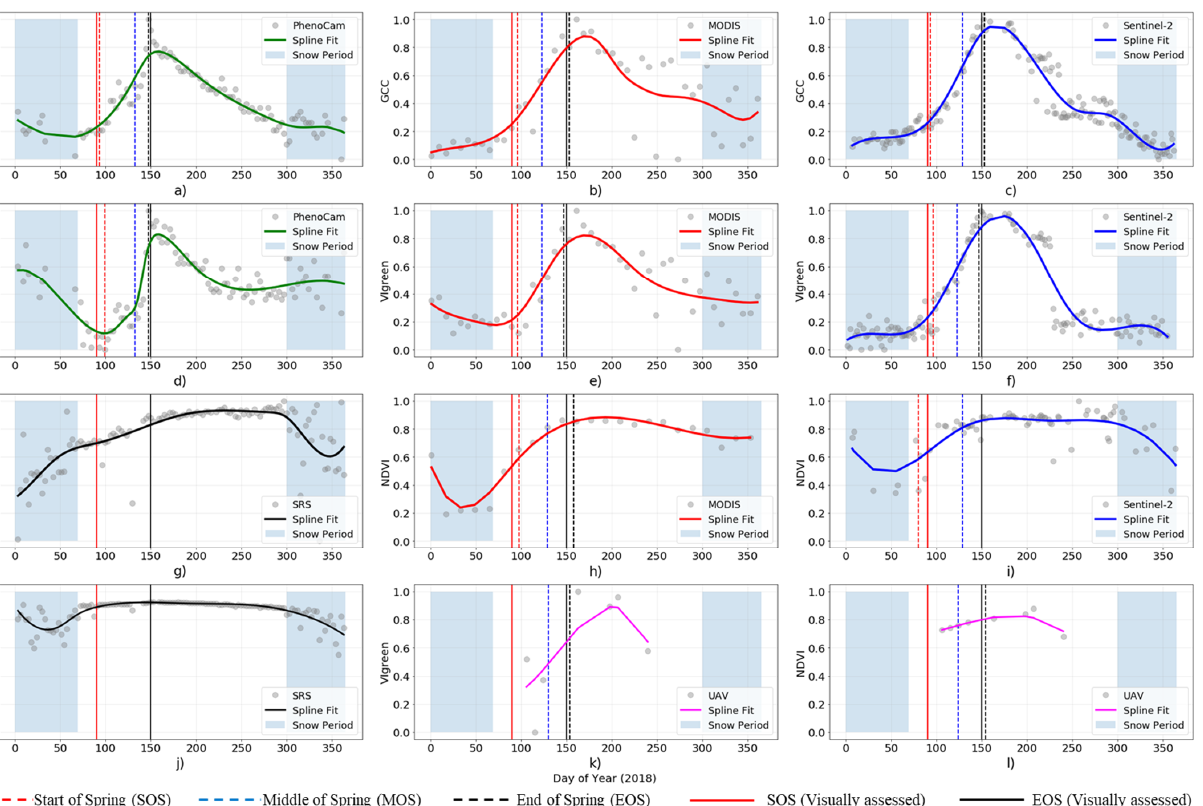
Figure 9. Time series and corresponding spline fit of normalized values of ( a ) PhenoCam-GCC, ( b ) MODIS-GCC, ( c ) Sentinel-2-GCC, ( d ) PhenoCam-VIgreen, ( e ) MODIS-VIgreen, ( f ) Sentinel-2-VIgreen, ( g ) SRS-VIgreen, ( h ) MODIS-NDVI, ( i ) Sentinel-2-NDVI, ( j ) SRS-NDVI, ( k ) UAV-VIgreen, and ( l ) UAV-NDVI. Grey circles represent the normalized raw VI values from respective sensors. Phenophase dates are marked by the vertical dashed lines (legend). The SOS and EOS from visual assessments of PhenoCam images are also shown for comparison